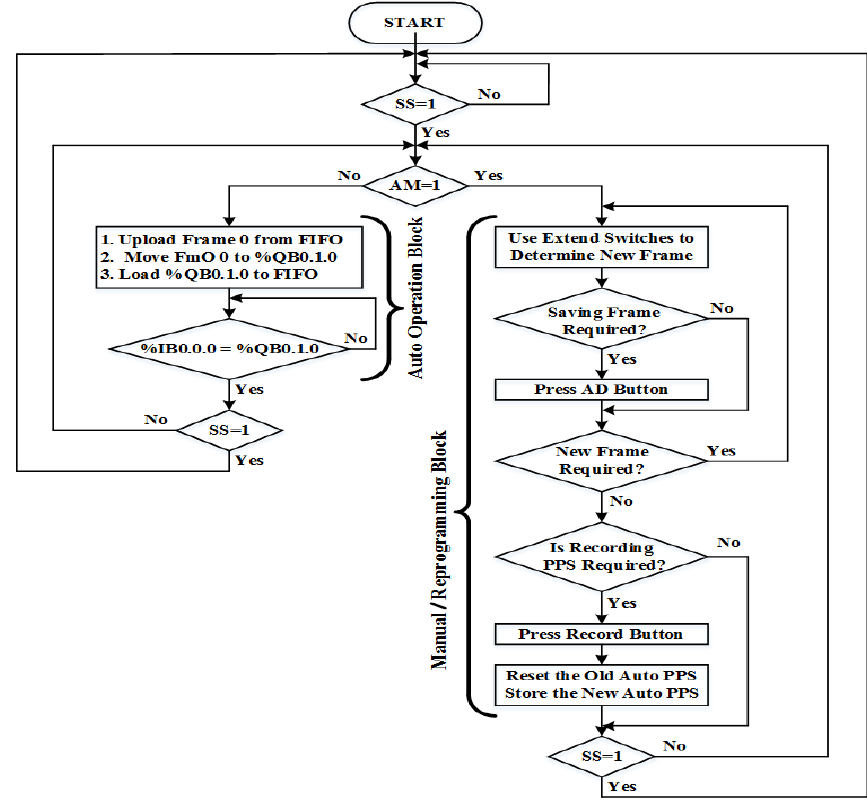
Fig. 7. PLC Logic Program Detailed